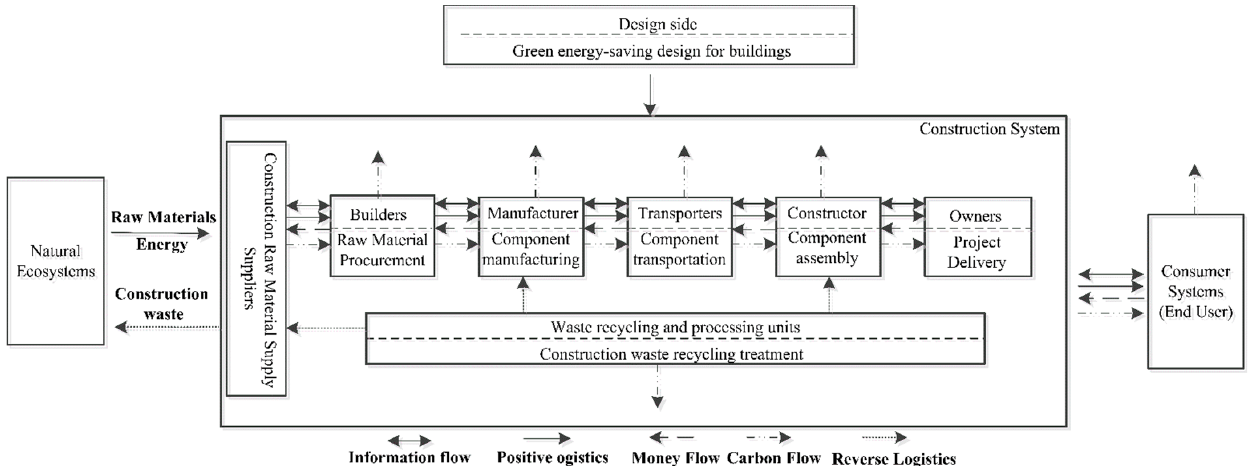
Table 1. Full life cycle carbon emission source.